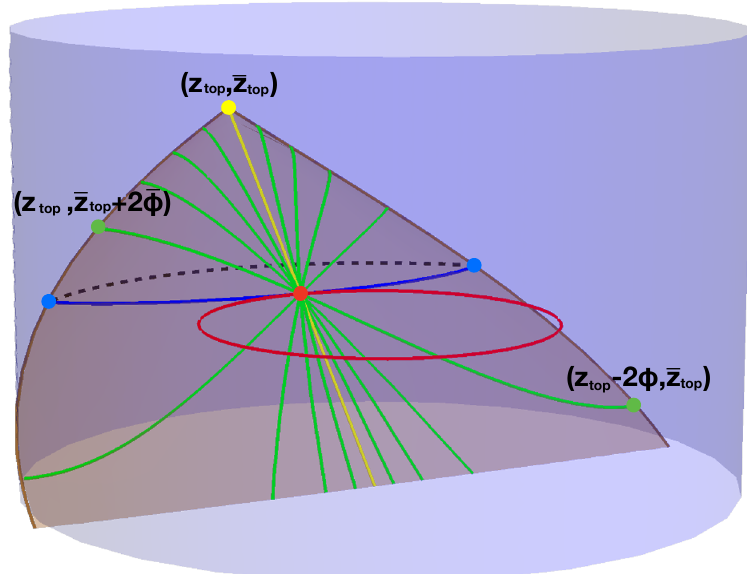
Figure 5 . The geodesics from the outgoing family, which are NVA to the bulk curve (red) at a common point. In pure AdS 3 , such geodesics are contained in and span the null plane, which is generated by the orthogonal outgoing lightray n o (yellow) and the tangent geodesic (blue). All these NVA geodesics end on boundary lightrays z R = z top and (cid:22) z L = (cid:22) z top , which is where the null plane meets the asymptotic boundary. The coordinates ( z R ; (cid:22) z L ) = ( z top ; (cid:22) z top ) are therefore common to all these NVA geodesics, independent of the gauge freedom parameterized by (cid:30) and (cid:22) (cid:30)